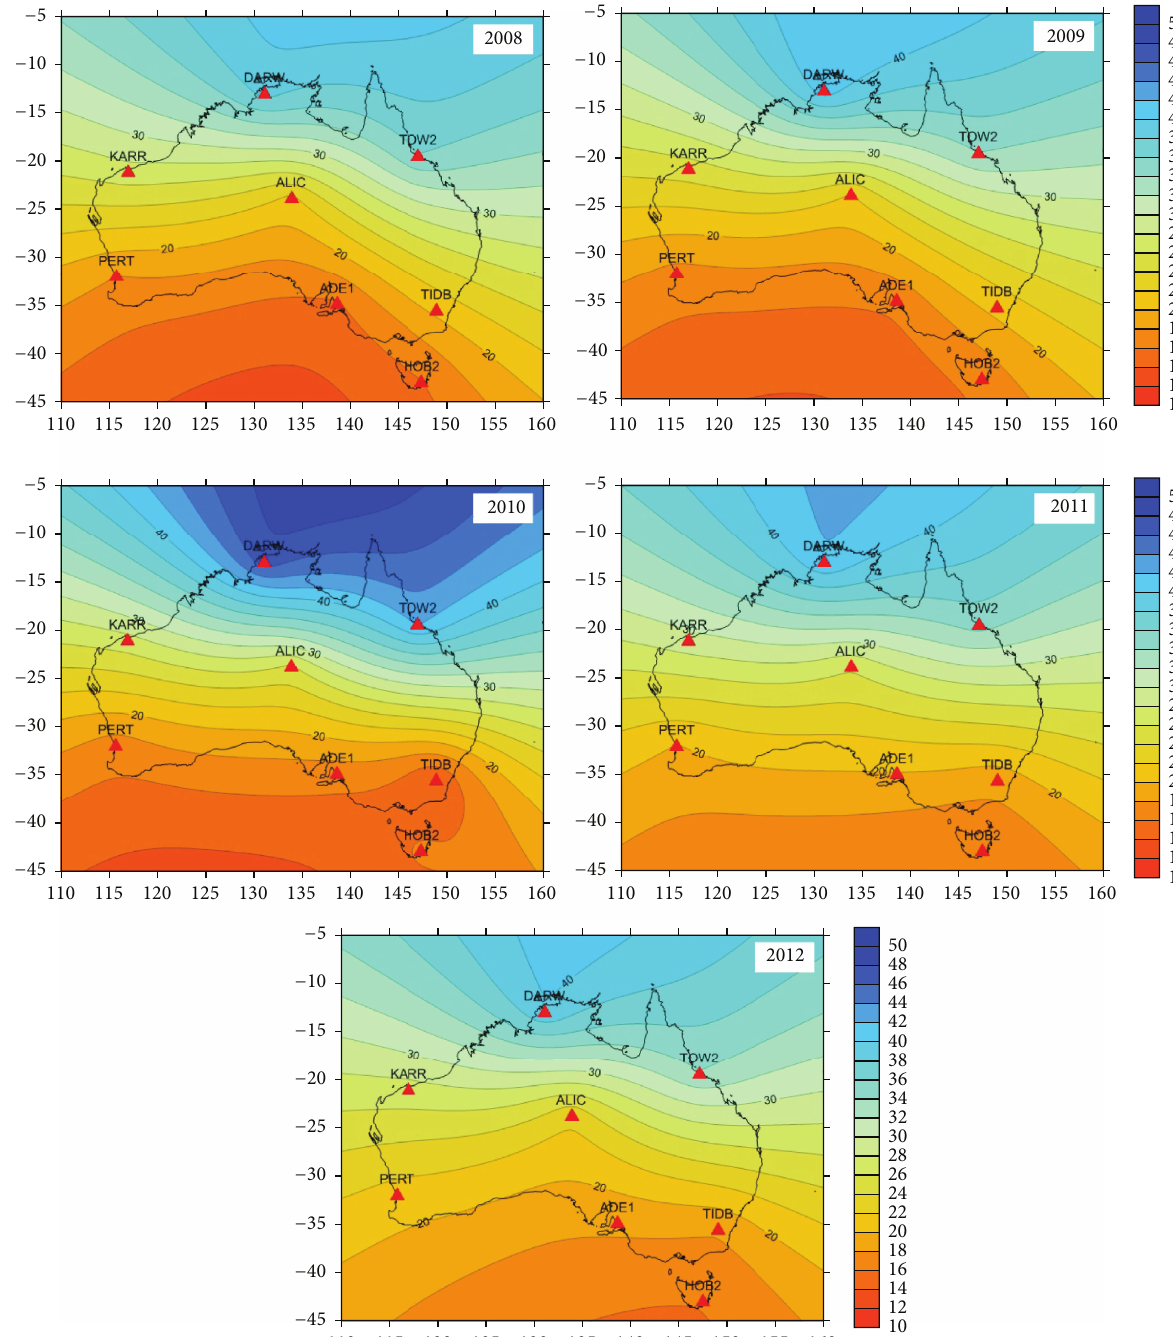
Figure 8: Distribution of mean GPS PWV (mm) over Australia from 2008 to